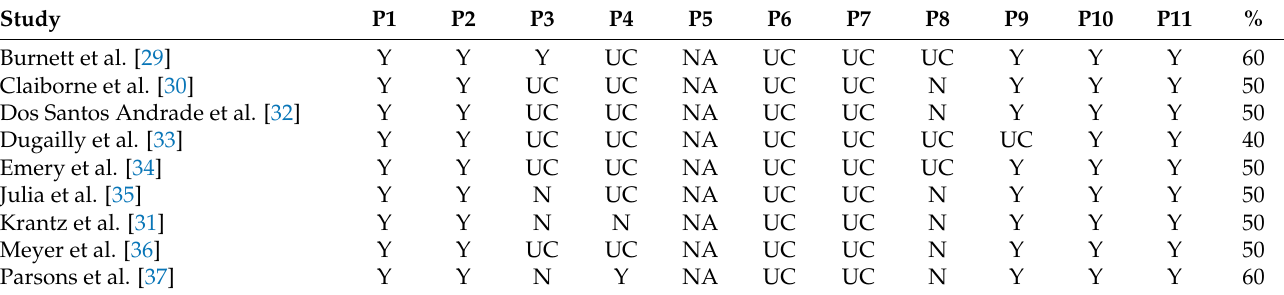
Table 6. Evaluation of the quality of studies with the QAREL